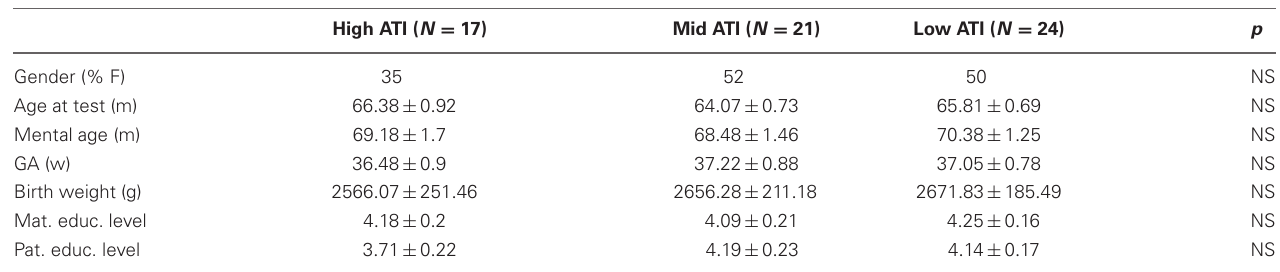
Table 1 | Demographic characteristics (mean ± standard errors) of the participants in each group. High ATI ( N =